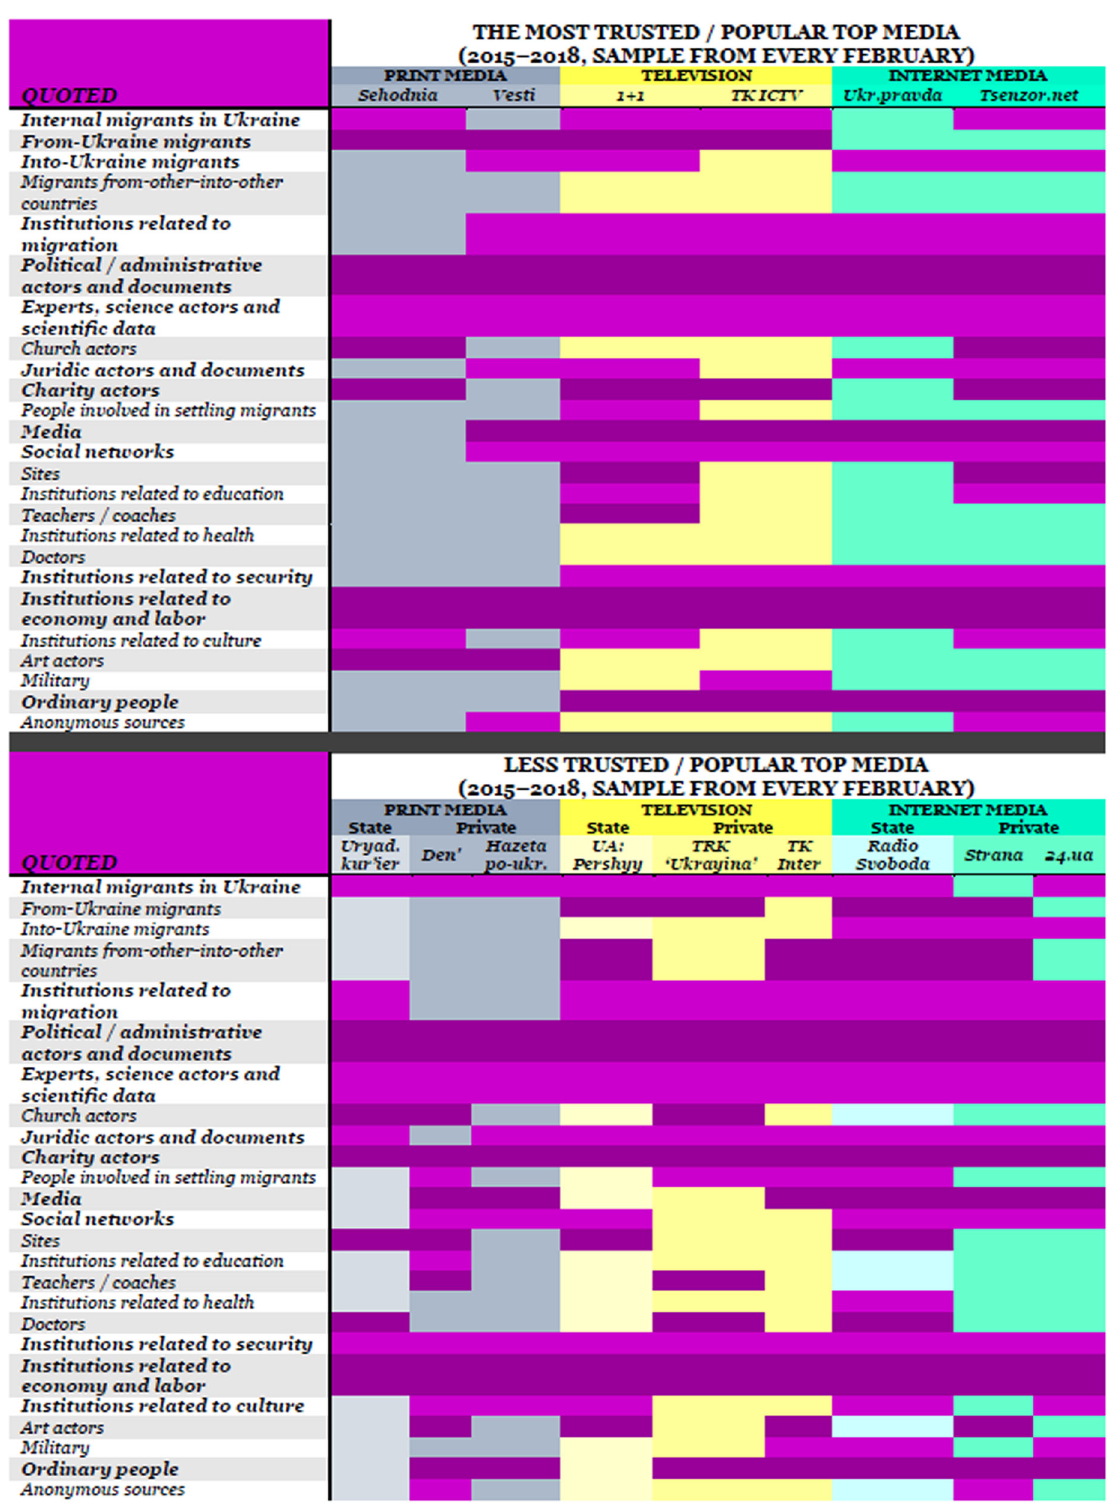
Fig. 6 Quoting different actors on migration and migrants in different types and subtypes of Ukrainian top media (2015 – 2018, sample from every February messages). Source: A. Tashchenko ’ s elaboration based on qualitative content analysis (by L. Yuzva and A. Tashchenko), analysis of discourse positions and sociocognitive critical discourse analysis (by A. Tashchenko) of media messages. Data source: The Center for Content Analysis research based on quantitative media content analysis, 2019. The comparative illustration demonstrates the similarities and differences in the presence (indicated by lilac and dark lilac for better line-by-line perception) or absence of direct and indirect quotes of different actors in the media with different discourse positions. All other colors are used to delimit areas for the sake of visual convenience. Additional bold highlighting leftward shows the names of the most frequently quoted groups of actors.